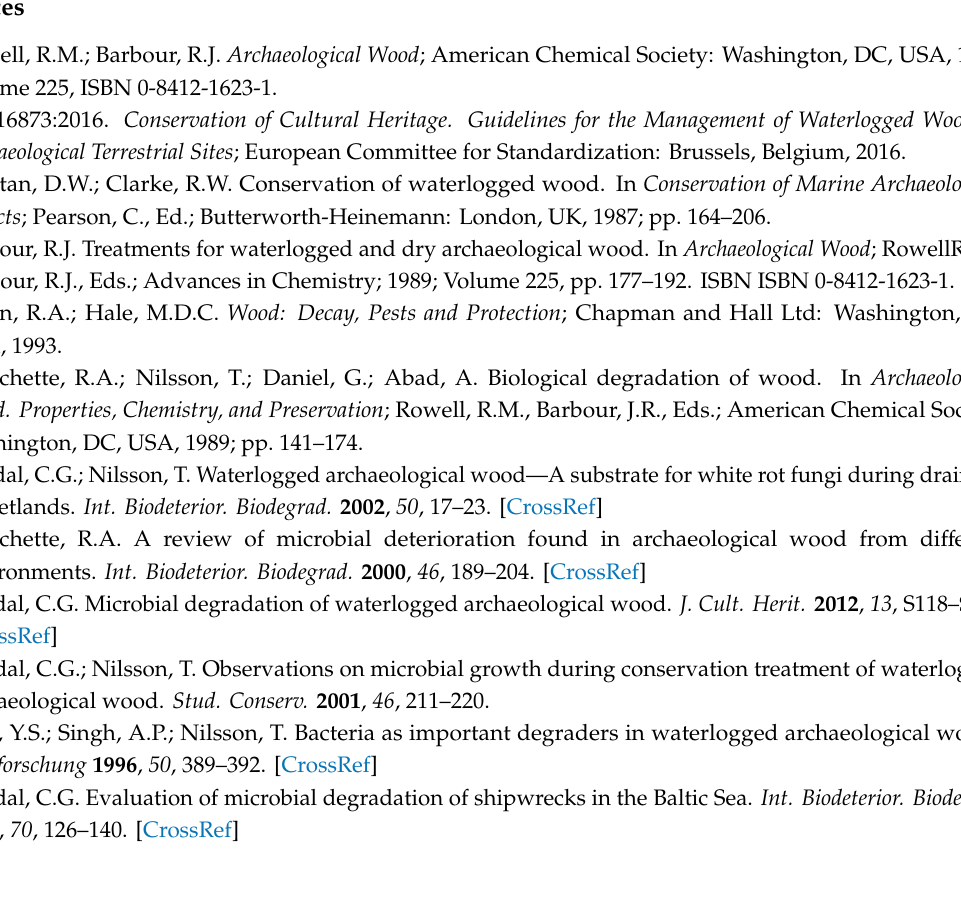
Table S1: Raw data obtained for 16S and ITS with the two extraction protocols. Figure S1: 16S. Stacked barcharts of the taxonomic profile at class level, Figure S2: 16S. Stacked barcharts of the taxonomic profile at family level, Figure S3: ITS2. Stacked barcharts of the taxonomic profile at class level, Figure S4: ITS2. Stacked barcharts of the taxonomic profile at family level, Figure S5: ITS2. Stacked barcharts of the taxonomic profile at species level. Author Contributions: Conceptualization, F.A., G.G. and F.G.; Formal analysis, A.E. and S.P.; Funding